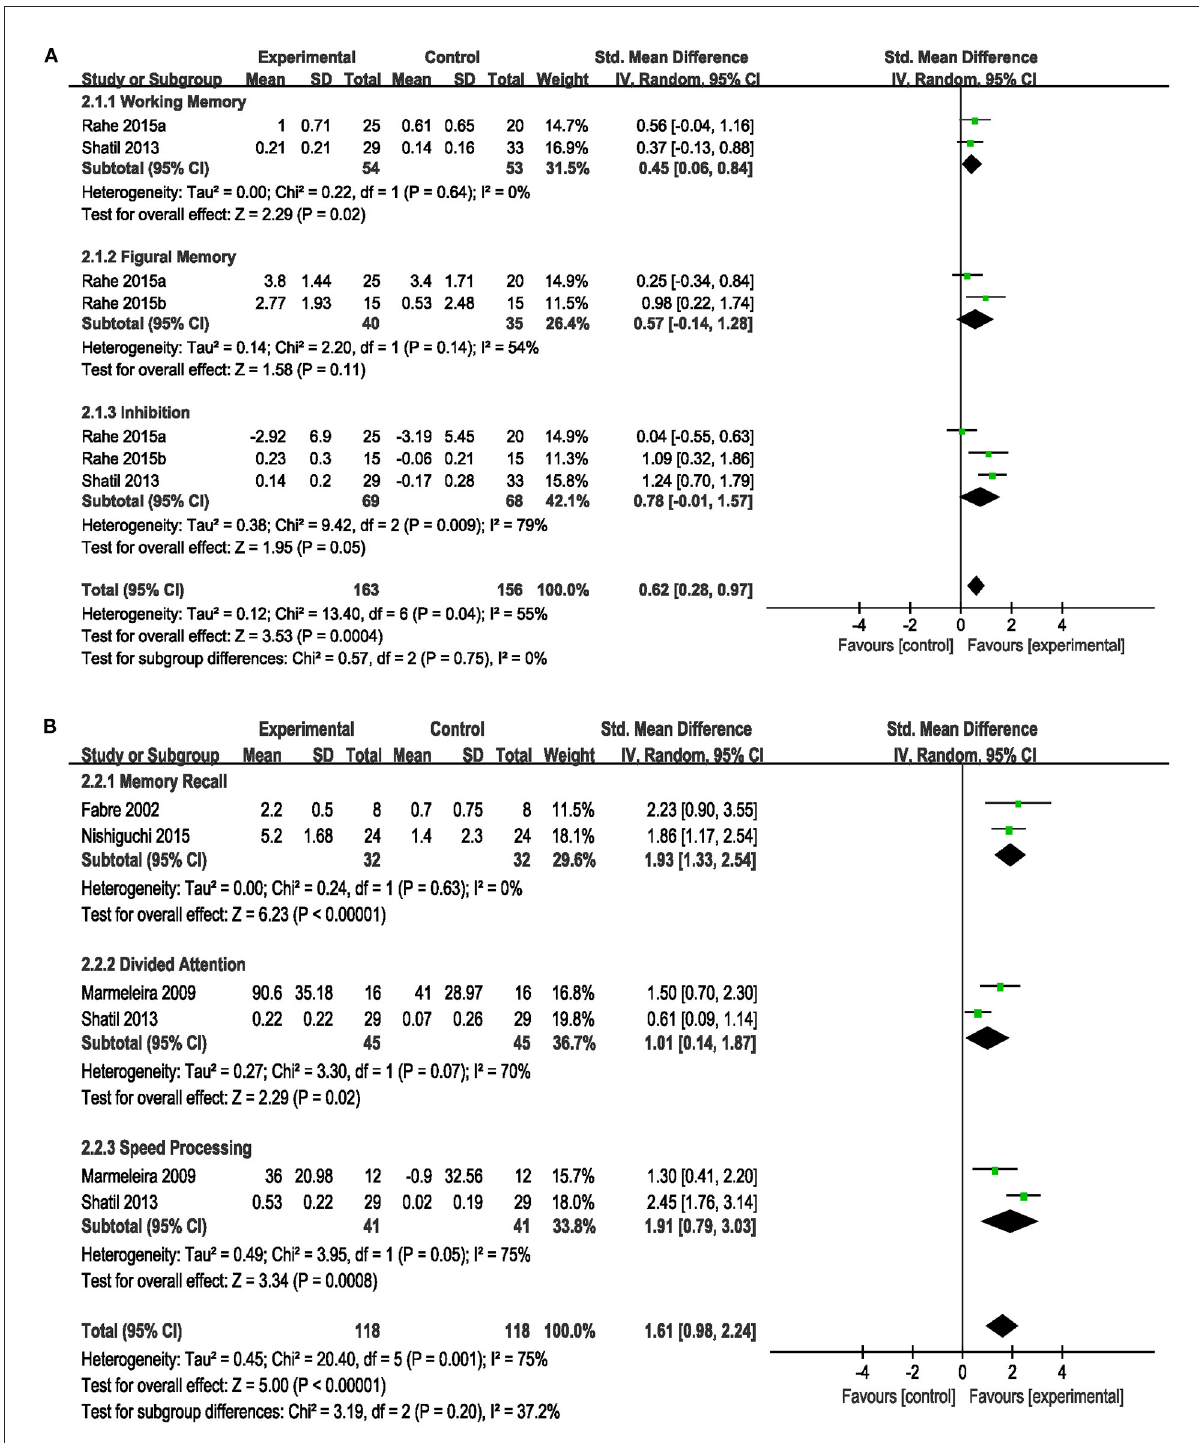
FIGURE4 Forest plot of the efficacy of the combined intervention on cognition domains in cognitively healthy older adults. (A) Combined intervention vs. single cognitive intervention, (B) combined intervention vs. sham